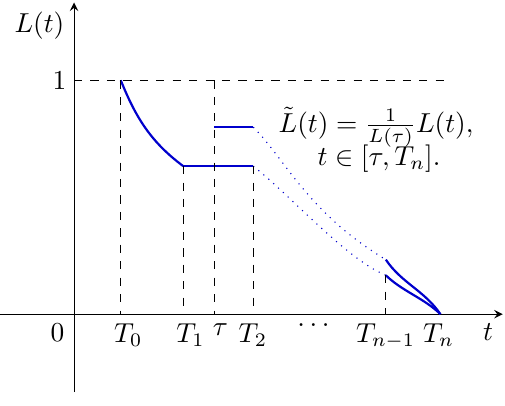
Figure 1. Discounting function for a game and for the subgame starting at t = τ